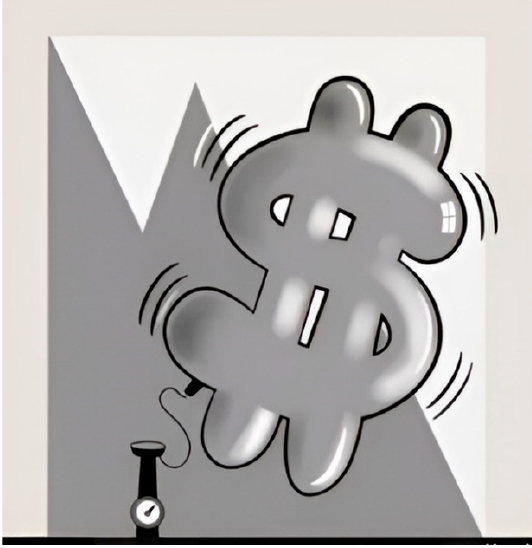
Figure 2. Visual metaphor of the “inflation” concept. Source: www.investopedia.com. Available online: http://bit.ly/3HesRLA (archived on 23 January 2023).